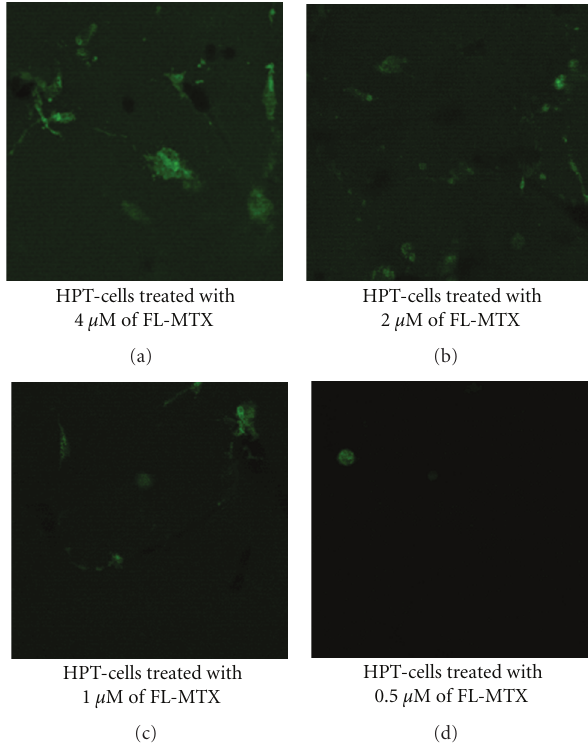
Figure 1: Confocal images of FL-MTX uptake by HPT cells in 24 well plates. Cellular fluorescence was more when the cells treated with 4 μ M FL-MTX and it was gradually decreasing when the cells were treated with 2 μ M, 1 μ M, and 0.5 μ M FL-MTX. Thus, FL-MTX uptake was directly proportional to its concentrations.